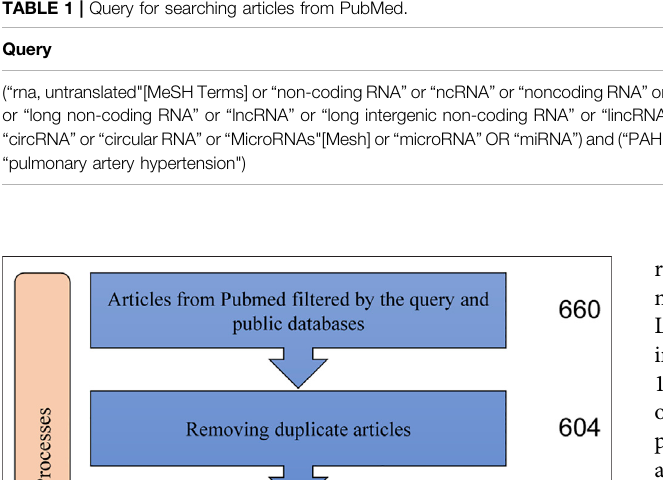
Frontiers in Genetics |